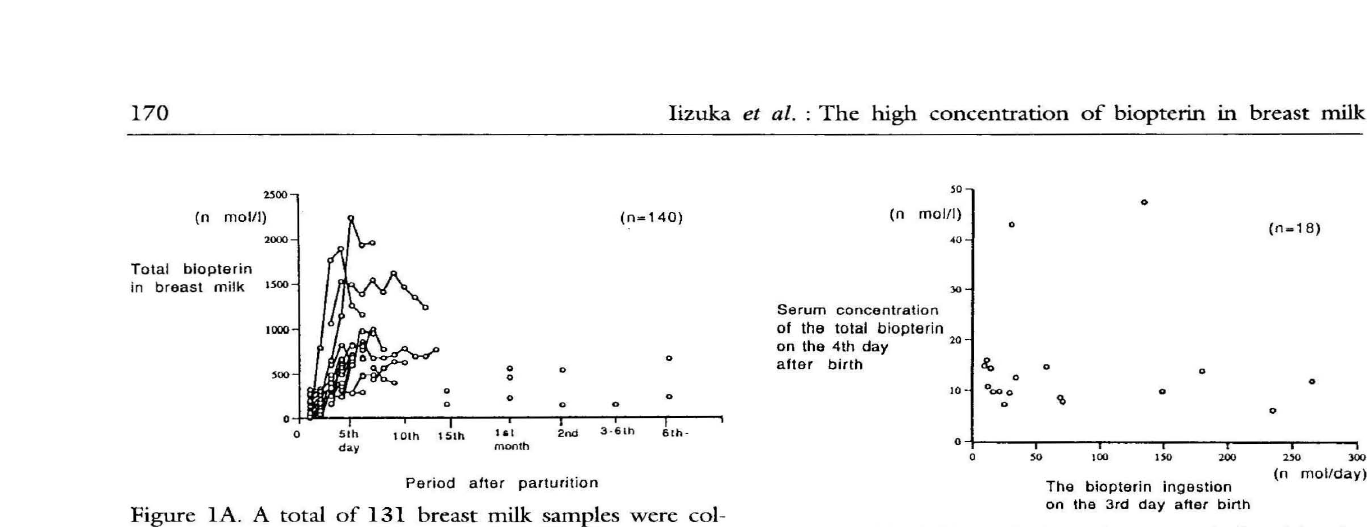
Figure lA. A total of 131 breast milk samples were col lected from 18 women, whose babies ranged from 1st to 13th days postpartum. Milk samples were taken 4 to 13 times during the duration of this study. An additional 10 samples were taken from a further 10 women, whose in fants were from 14 day to 10 month old. The total biopterin concentrations were assayed as described in the text. Each case was traced by a solid line.